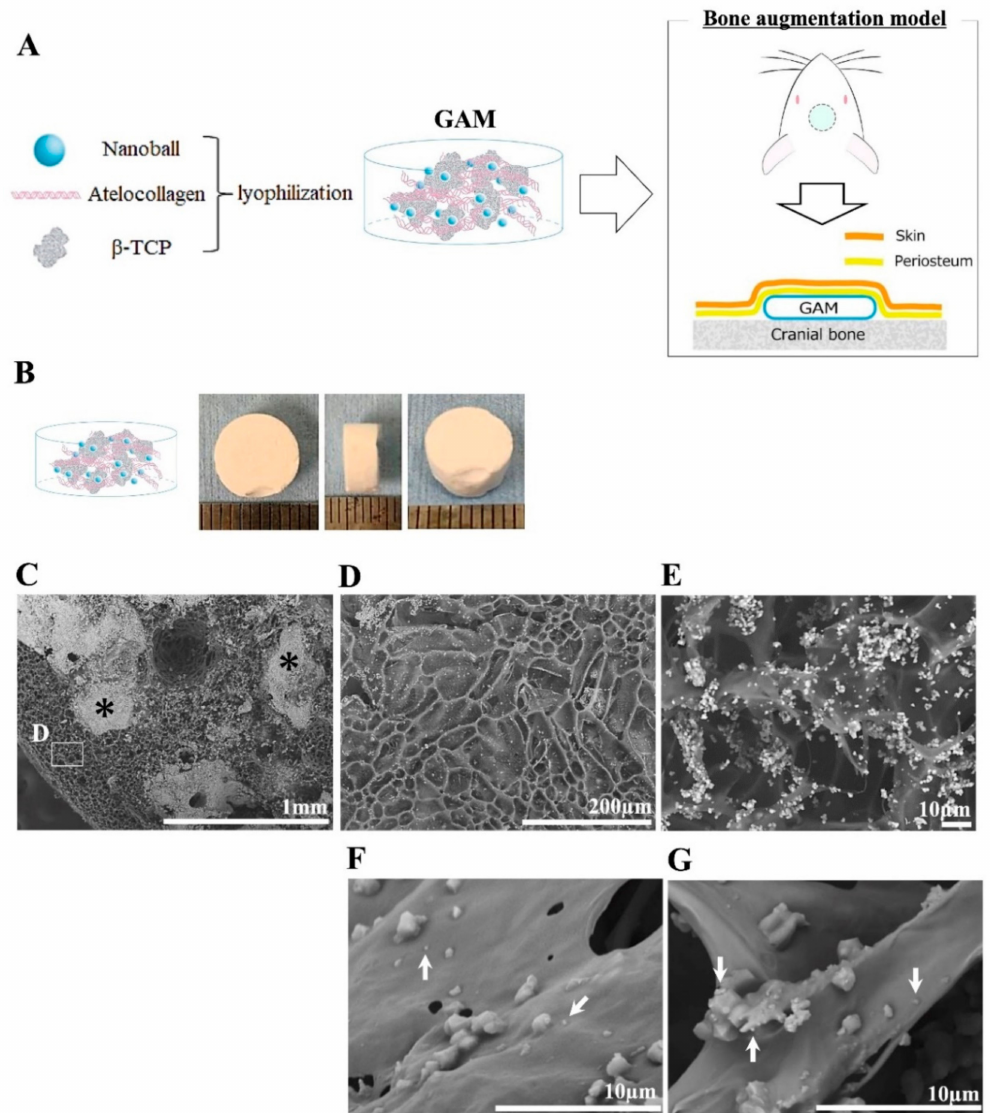
Figure 4. Manufactured GAM for bone augmentation. ( A ) Schematic diagram describing the experimental design for the preparation and transplantation of GAMs onto rat cranium as a bone augmented model. ( B ) Gross appearance of manufactured GAM. ( C – G ) SEM images of GAM composed of atelocollagen, β -TCP granules, and nanoballs. Asterisks in ( C ): 500–1000 µ m β -TCP granules. Scale bar, 1 mm; ( D ) the white box area in ( C ) is shown at higher magnification. Scale bar, 200 µ m; ( E – G ) parts of the area in ( D ) are shown at higher magnification. Scale bar, 10 µ m. White arrows in ( F , G ): uniform nano-sized particles determined to be nanoballs at higher